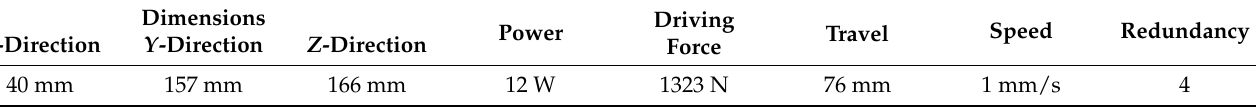
Figure 6. Components of the driving subassembly. Table 3. Properties of the driving subassembly